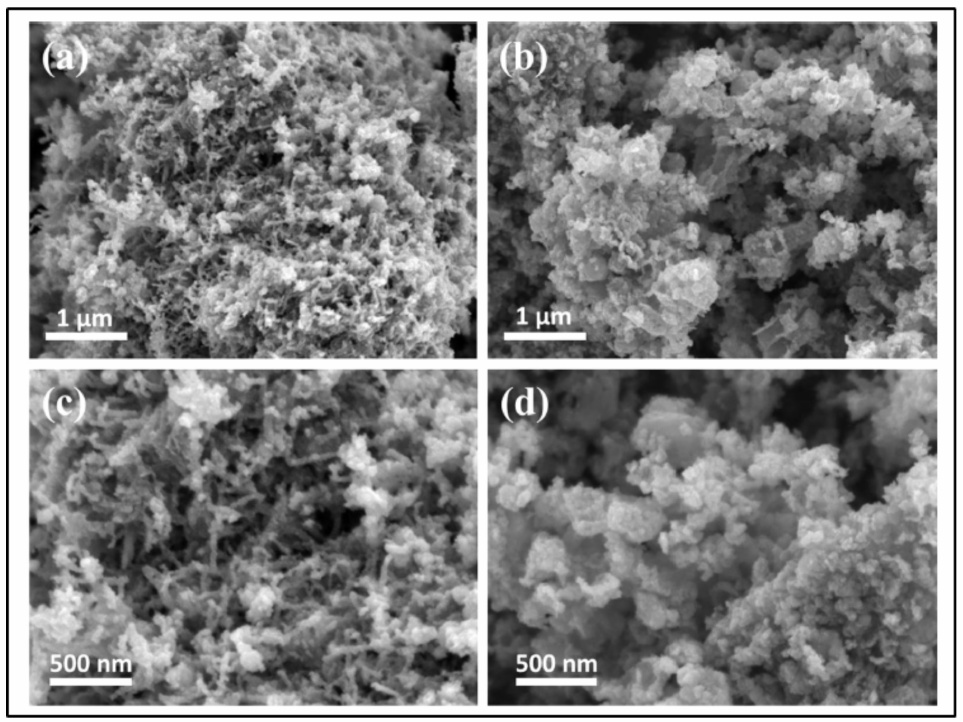
Figure 11. SEM of ( a , c ) CNTs/MnCo 2 S 4 and ( b , d ) MnCo 2 S 4 . Adapted with permission from [130] Copyright 2022, American Chemical